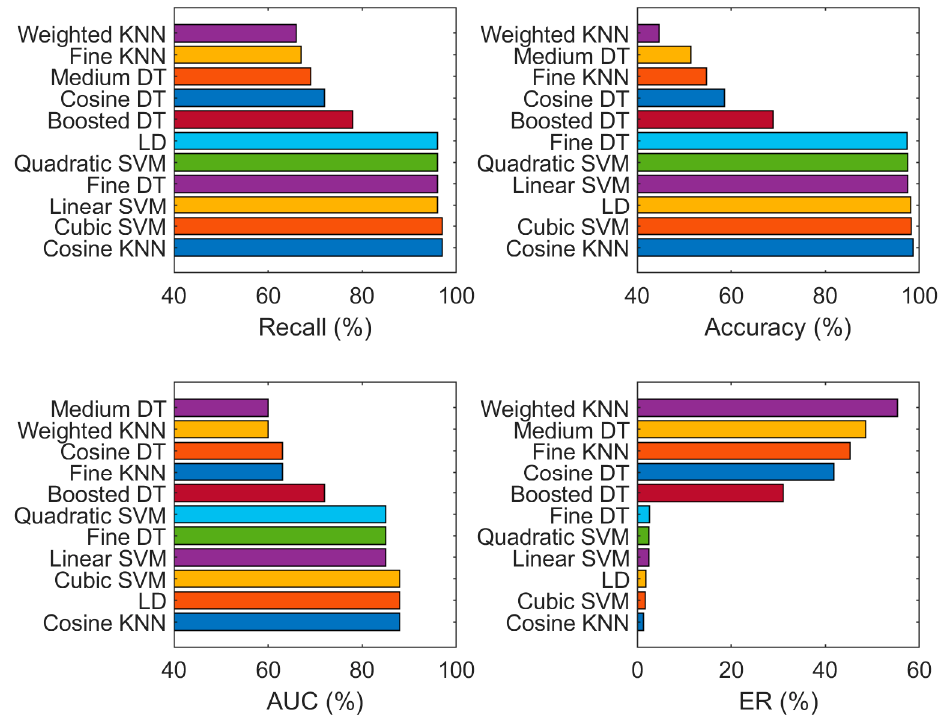
Figure 9. Classification results (recall, accuracy, AUC and ER) using a fusion of SFTA and pre-trained network features on the original (imbalanced) dataset.